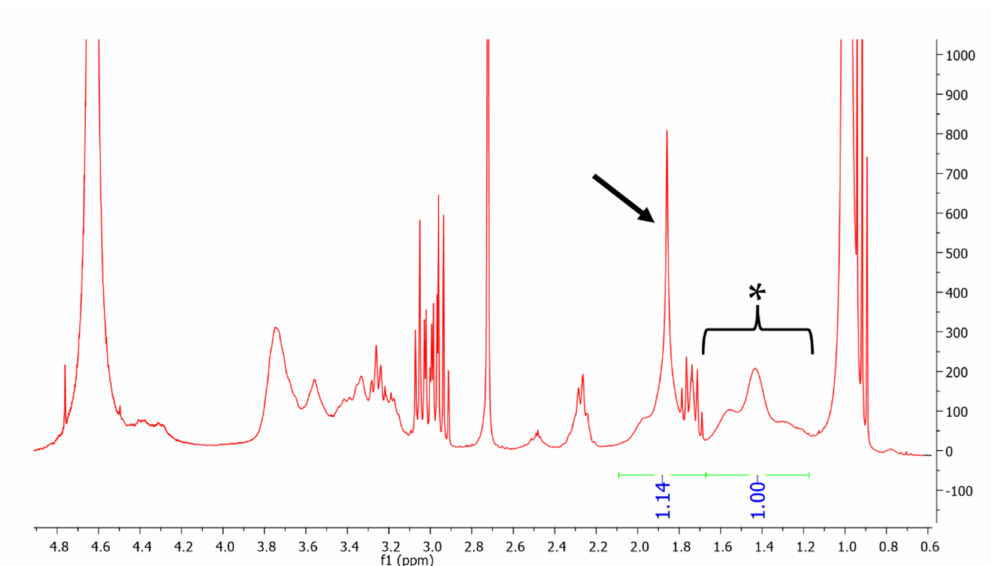
Figure 1. 1 H NMR spectrum of HApNIPAM copolymer showing 4.88% grafting of pNIPAM. The asterisk (1.1–1.7 ppm) represents the peak of 3 protons from the acetyl group of HA and that of 1 proton from the pNIPAM chain, and the arrow (1.7–2.1 ppm) represents the peak of 2 protons from the pNIPAM